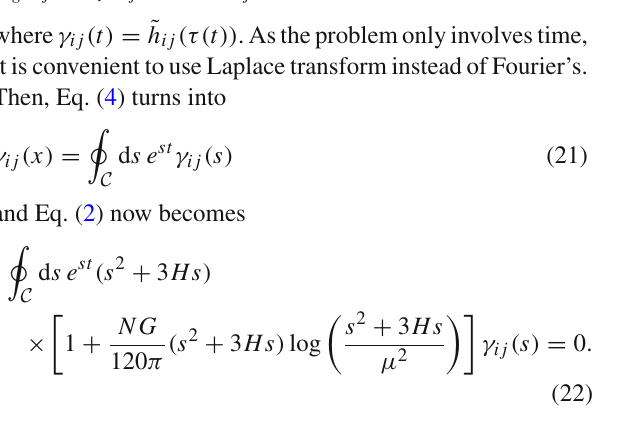
− − and s are damped while 2 3